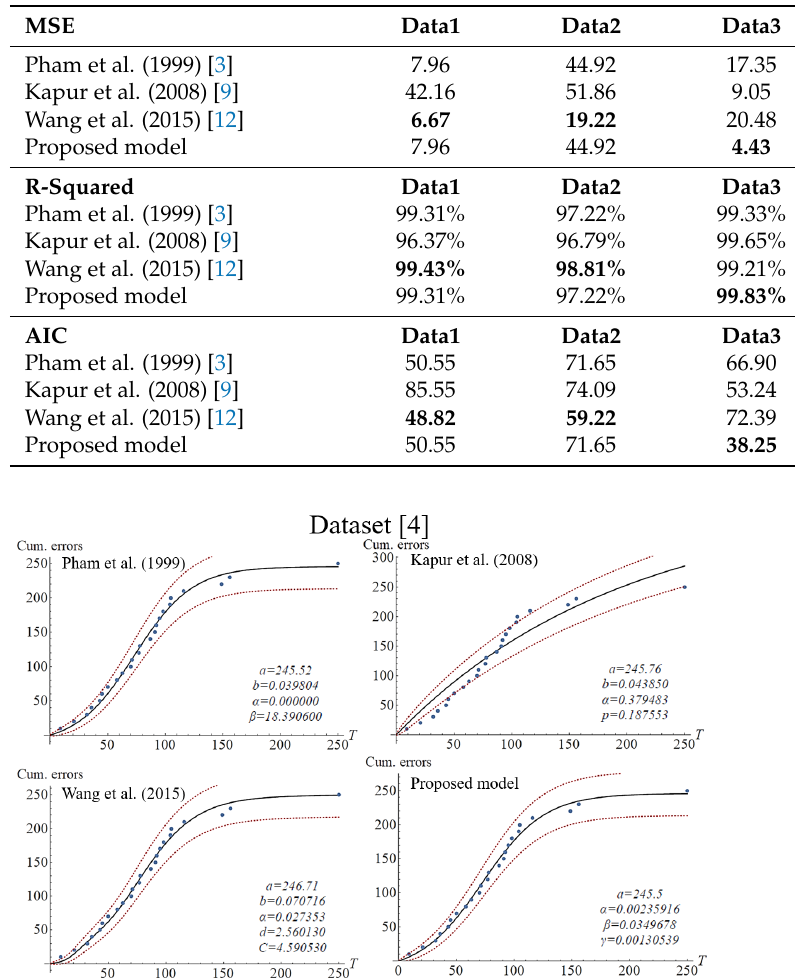
Figure 4. Goodness-of-Fit and Estimated Values of Models’ Parameters, and 95% Confidence Intervals for Dataset (3). Table 5. Comparisons of Different Fitting Criteria.